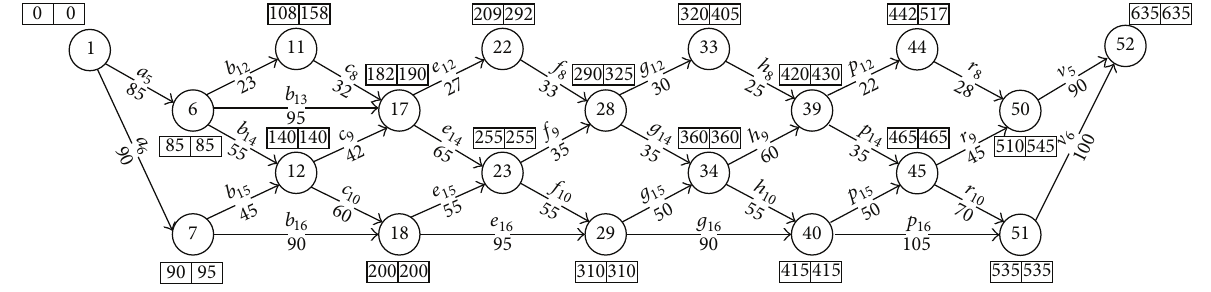
Figure 3: Network with nonredundant activities.